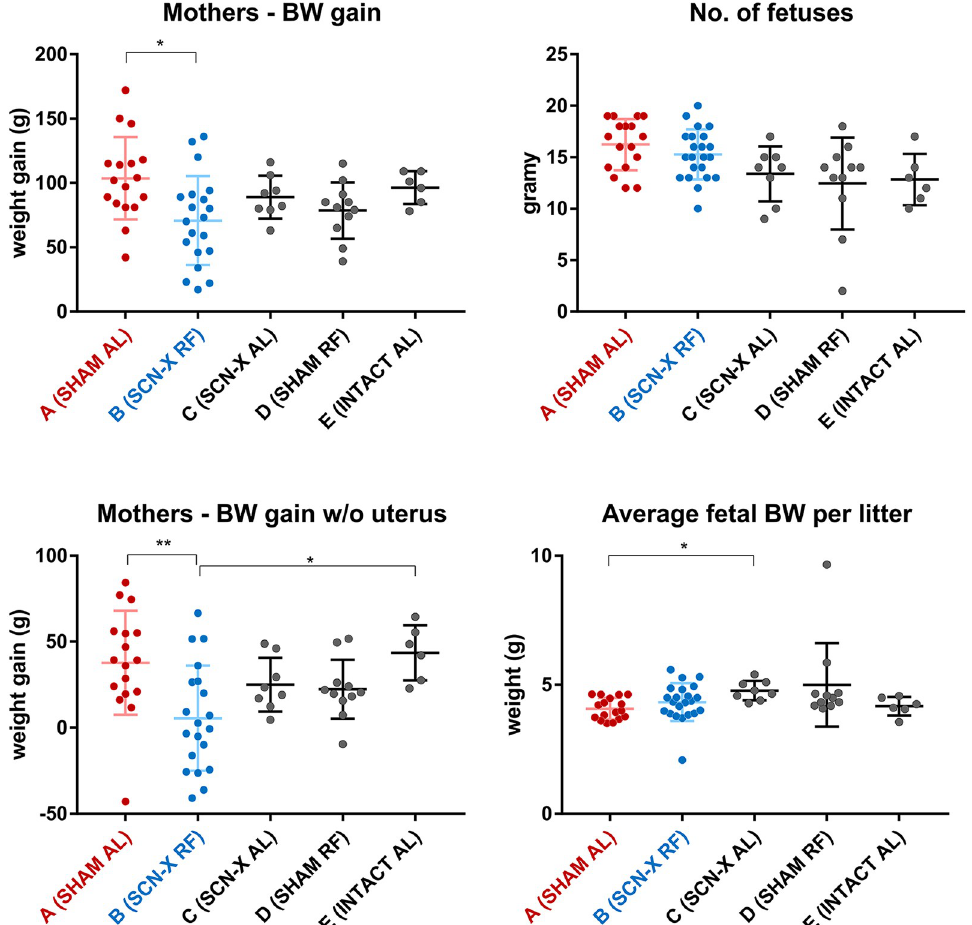
Fig 2. Effects of the SCN lesion and feeding regime on the BW and the size of the litter. The pregnant rats were either fed AL or exposed to tRF regime. Five groups of female rats were analyzed—sham-operated (SHAM) on AL feeding regime (Group A), SCN-X group on tRF (Group B), SCN-X group on AL (Group C), sham-operated on tRF (Group D), and intact controls on AL (Group E). BW gain during pregnancy was significantly lower in mothers of Group B compared to Group A; however, the number of fetuses per litter was not different between all groups. BW gain of mothers with uterus and fetuses removed was significantly lower for Group B in comparison with Groups A and E, and average BW of fetuses in Group A did not differ to Group B but was slightly lower compared to Group C. Analyzed by Kruskal–Wallis test with Dunn multiple comparisons, � P < 0.05, �� P < 0.01. For raw data, see S1 Data. AL, ad libitum; BW, body weight; SCN, suprachiasmatic nuclei; tRF, time-restricted feeding.